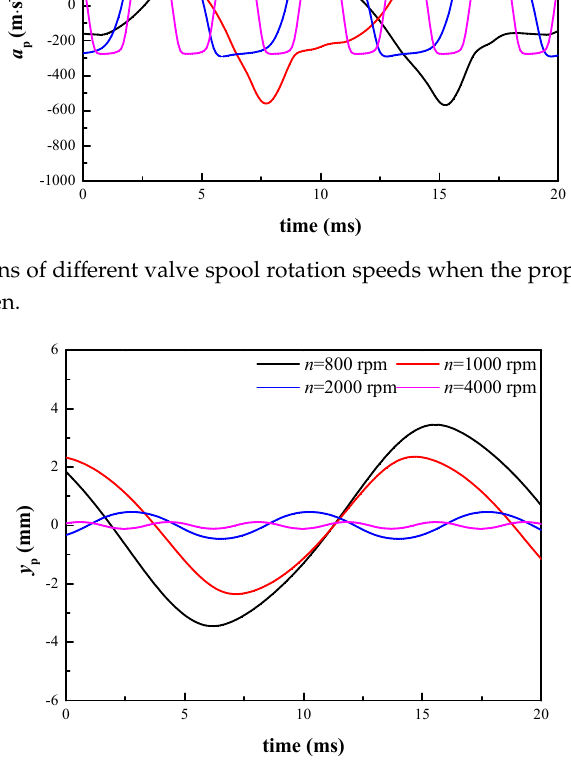
Figure 10. Displacements of different valve spool rotation speeds when the supply pressure is 4 MPa.